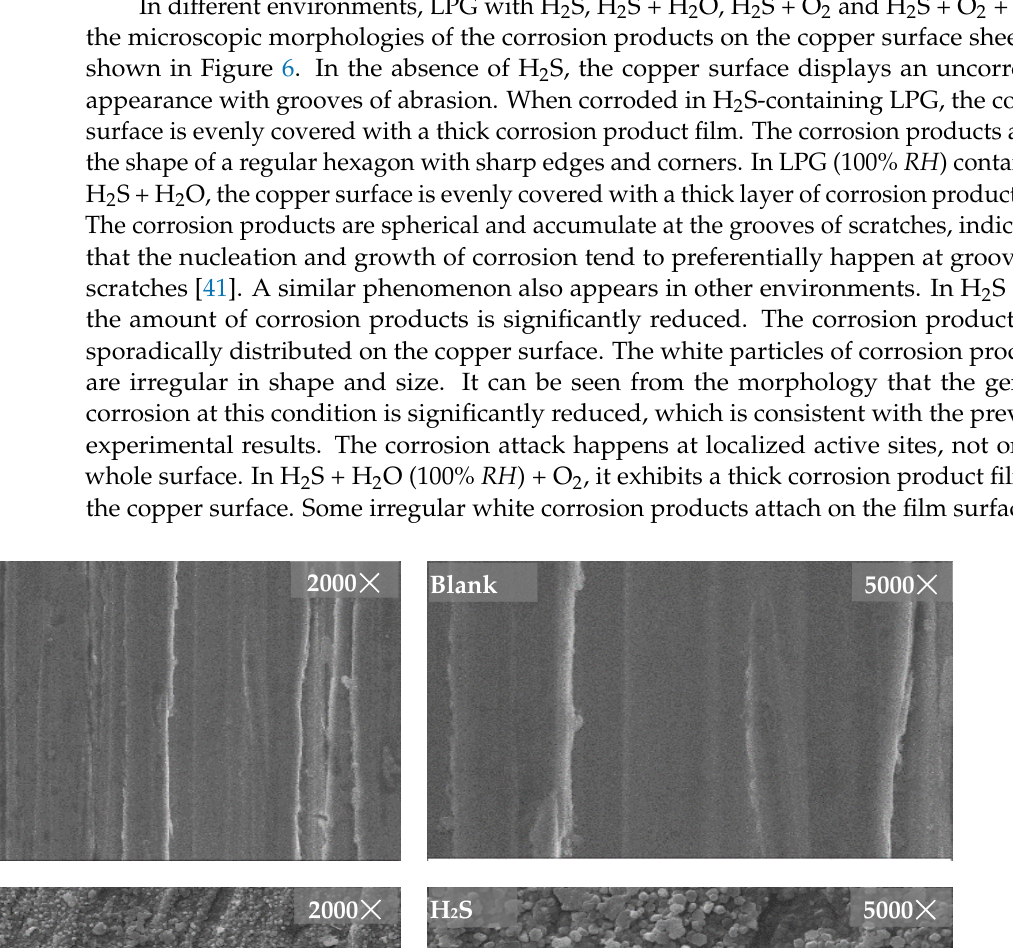
Figure 6. SEM images of corrosion products of copper sheets after corrosion tests in H 2 S, H 2 S + H 2 O, H 2 S + O 2 and H 2 S + O 2 + H 2 O.